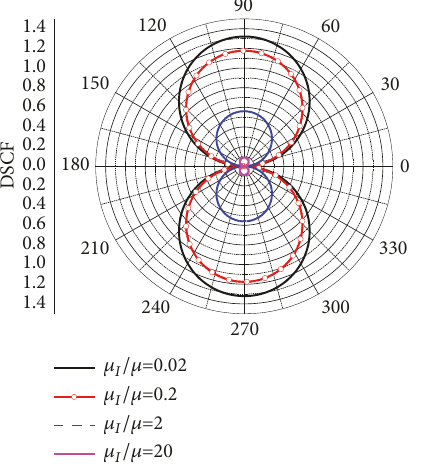
Figure 6: Effect of 𝜇 𝐼 /𝜇 on the DSCF with 𝐾 𝐼 /𝐾 = 0.2 .